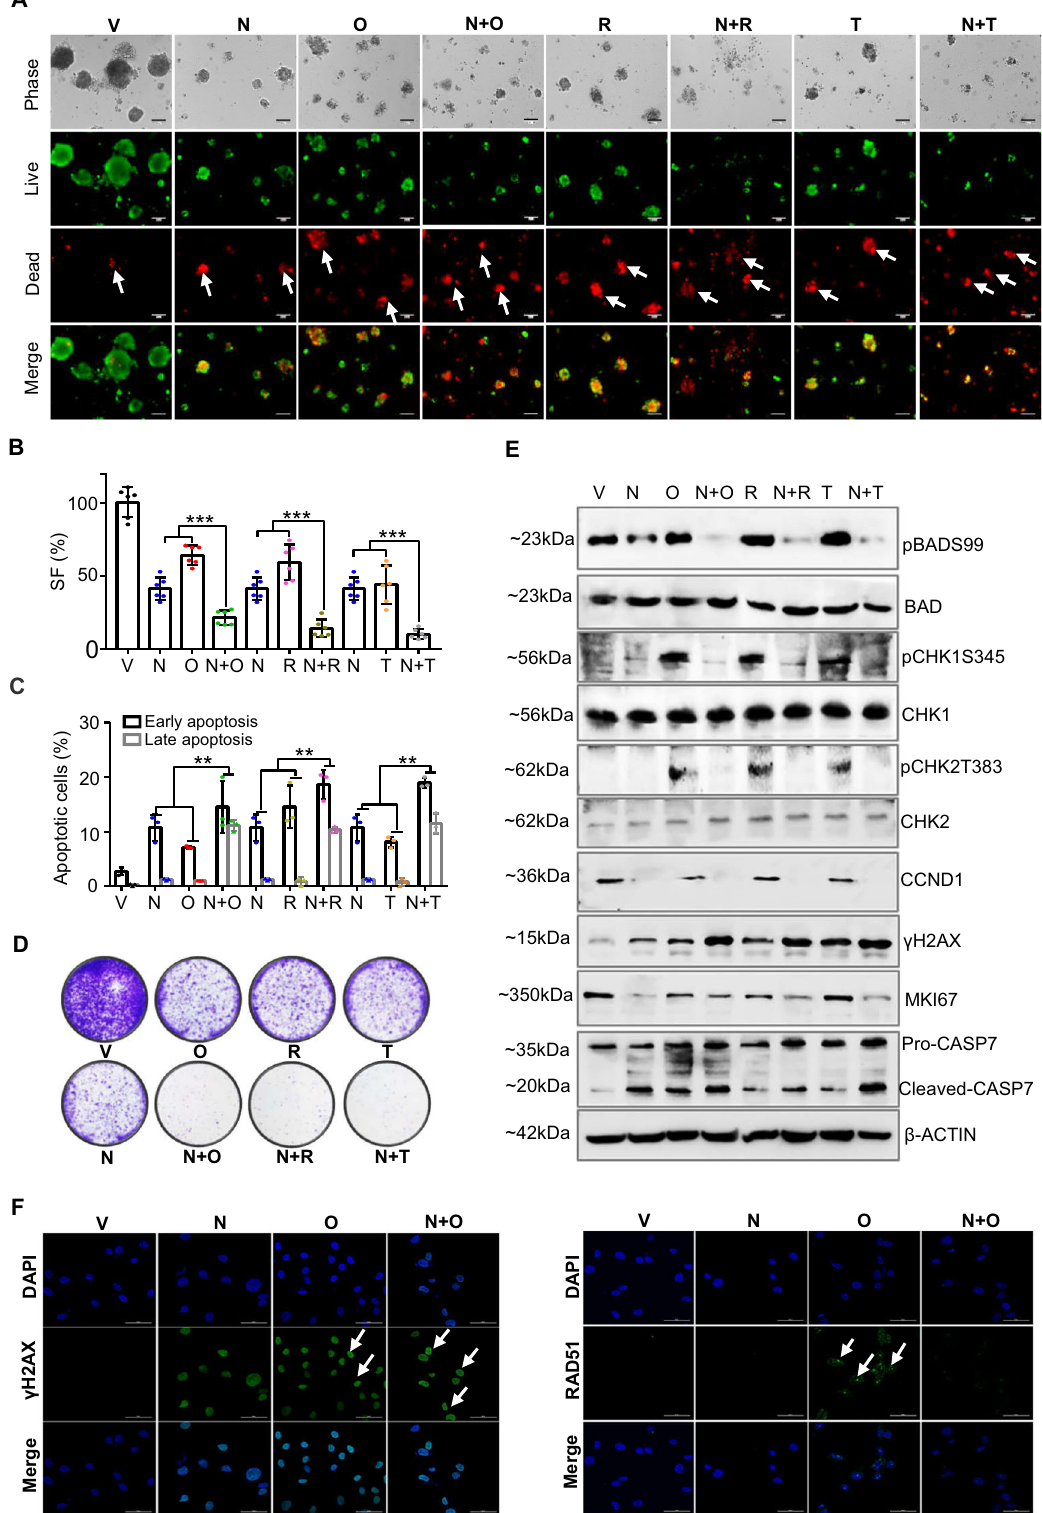
signi fi cantly decreased A2780 and A2780CisR cell-generated xenograft volume compared to Olaparib-treated animals. In addition, the A2780 and A2780CisR cell-generated xenografts treated with NPB-Olaparib exhibited signi fi cantly